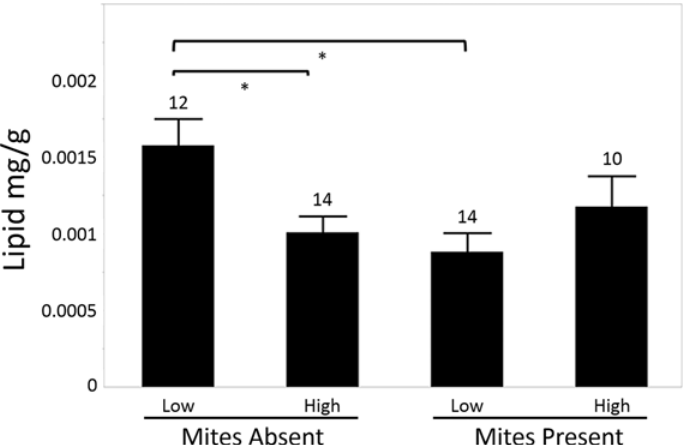
Fig 1. Relationship between landscape cultivation and lipid levels in absence of Varroa mite. Mean +/- SE of lipid concentration of bees from hives without mite infestations kept in low cultivation and high cultivation areas. Number of hives sampled indicated, * bracket indicate significant differences in lipid